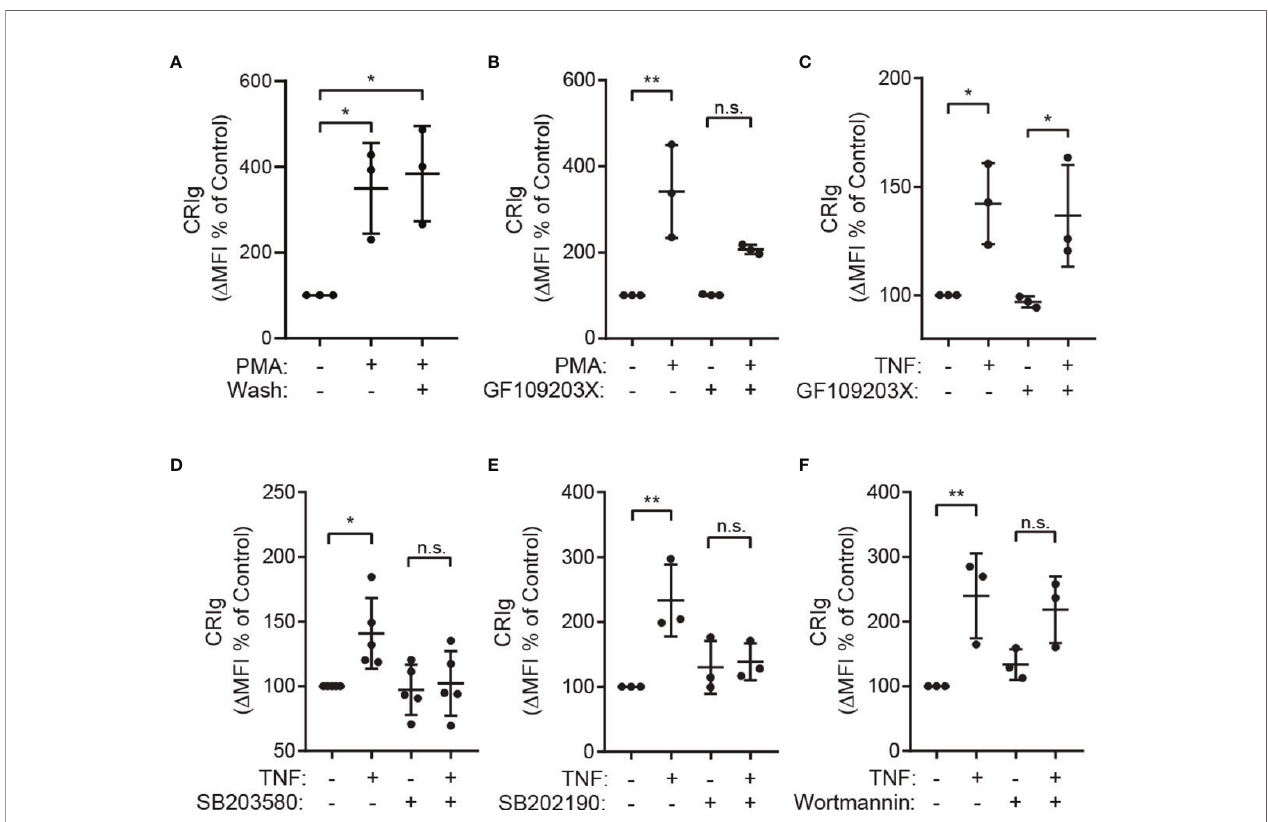
FIGURE 4 | The role of PKC and p38 MAP kinase in up regulation of CRIg expression. (A) Shows Effect of washing the cells following priming. Neutrophils were treated with 100 nM of PMA for 20 min and then washed and re-incubated for 1h. After incubation the level of CRIg expression was measured by fl ow cytometry. (B, C) Surface CRIg expression induced by PMA or TNF measured on neutrophils pre-treated for 10 min with 500 nM of the PKC inhibitor, GF109203X. (D, E) Effects of p38 inhibitors. Surface CRIg induced by TNF on neutrophils pre-treated for 30 min with either 10 µM SB203580 or 20 µM SB202190. (F) Effects of PI3 kinase inhibitor, wortmannin. Surface CRIg induced by TNF on neutrophils pre-treated for 10 min with 100 nM wortmannin. Expression was assessed as described in Figure 1 with the calculated D MFI expressed as a percentage increase over control treatment. Measurements were taken from distinct specimens and graphs show mean ± SD of these measurements, Sidak ’ s post-test compared between TNF/PMA treatment and control or treatment in the presence of inhibitor. Signi fi cance levels are indicated by asterisks: * P < 0.05, ** P < 0.01, n.s., not signi fi